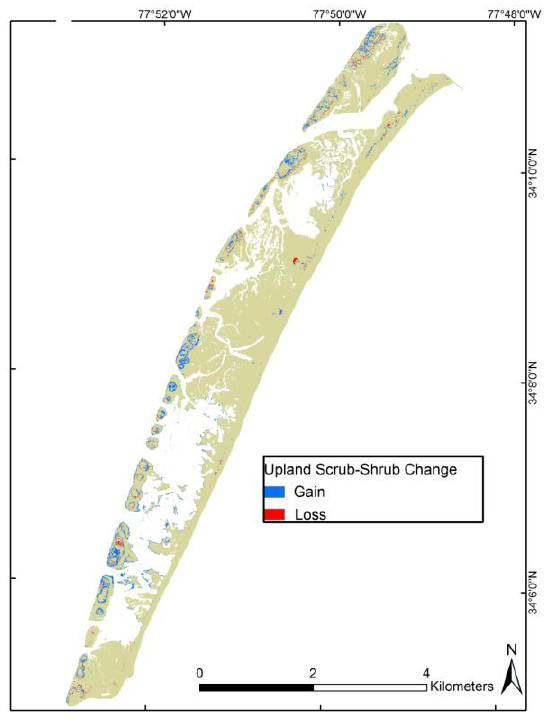
Figure 9. Gain (blue) and loss (red) in upland scrub/shrub for the entire study area *.